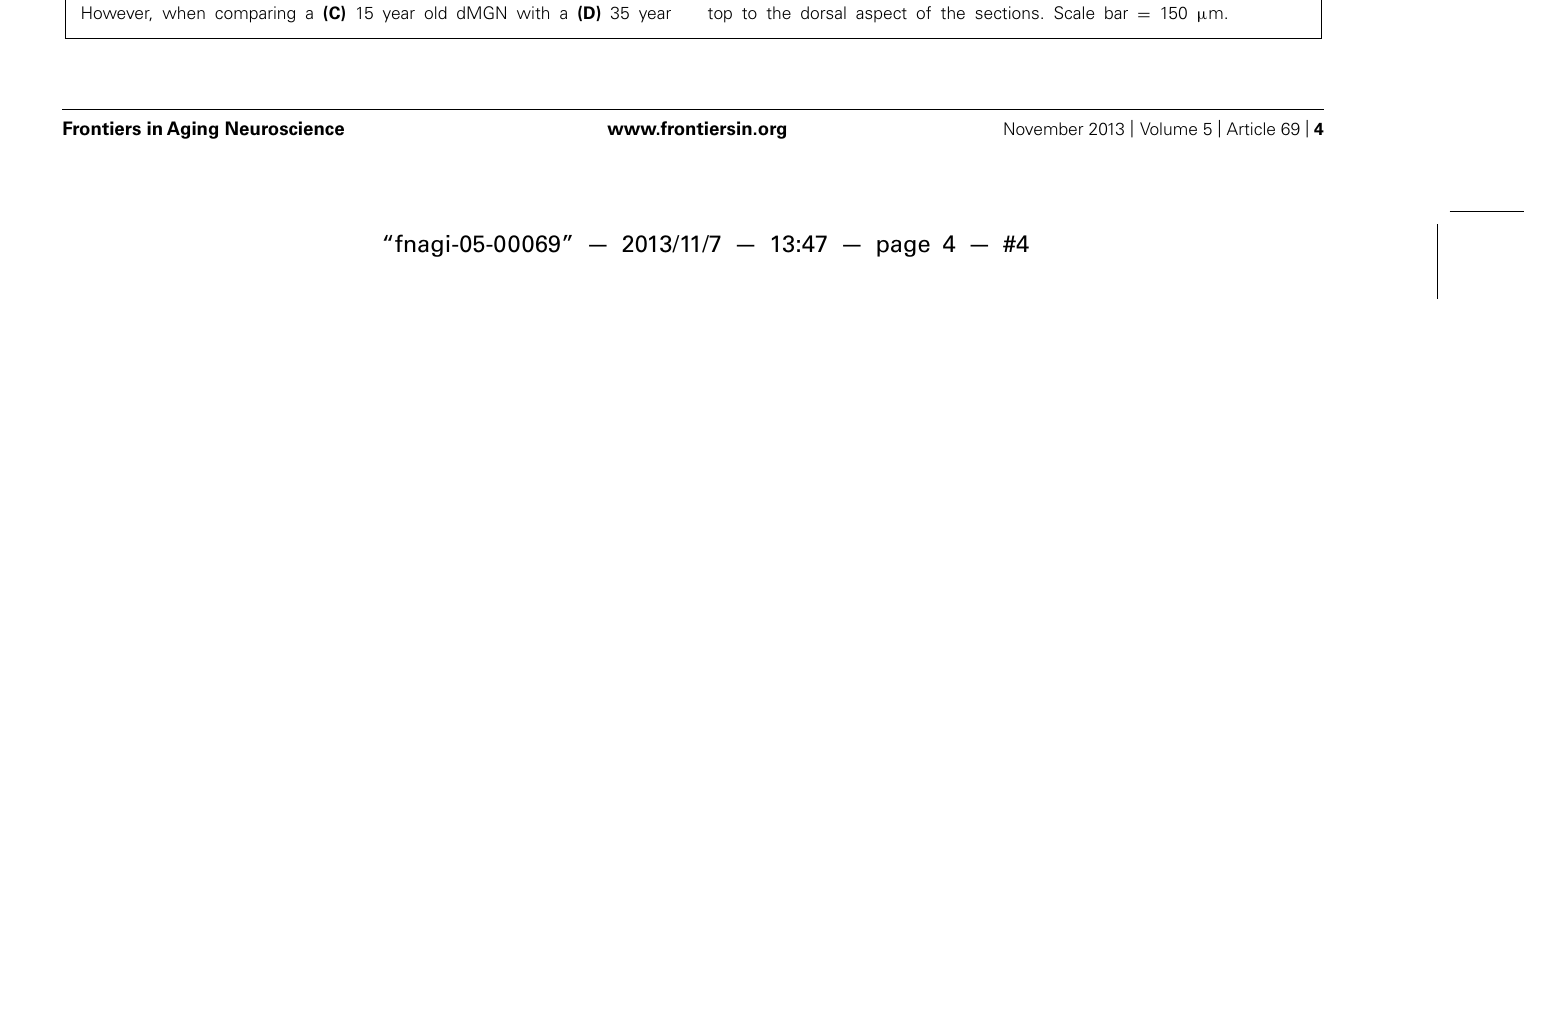
old dMGN, no apparent age-related changes in the number of stained neurons are seen. Similar to the vMGN, the mMGN showed age-related increases between the (E) 15 year old or and (F) 35 years old animals. The left side of this image corresponds to the medial aspect and the top to the dorsal aspect of the sections. Scale bar = 150 μ